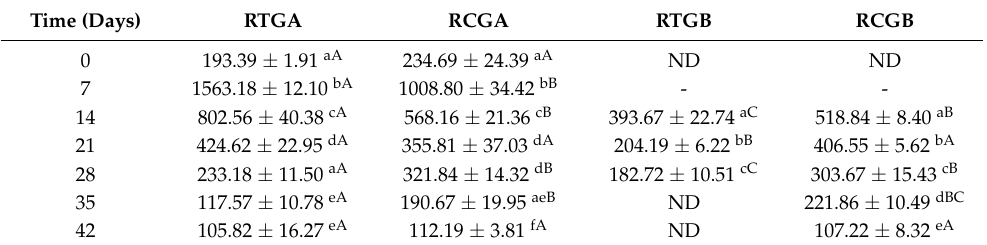
Table 1. Changing of SAC content after treated with thermal process method A and B in Thai garlic strain and Chinese garlic strain.